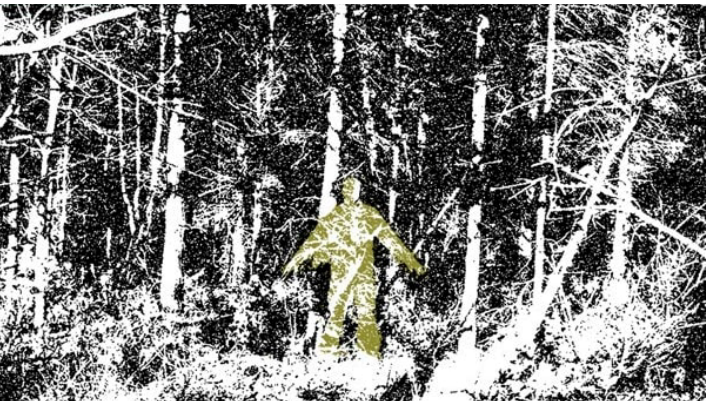
Figure 5. Example of determining the micro scale of a pattern on human silhouette [4].